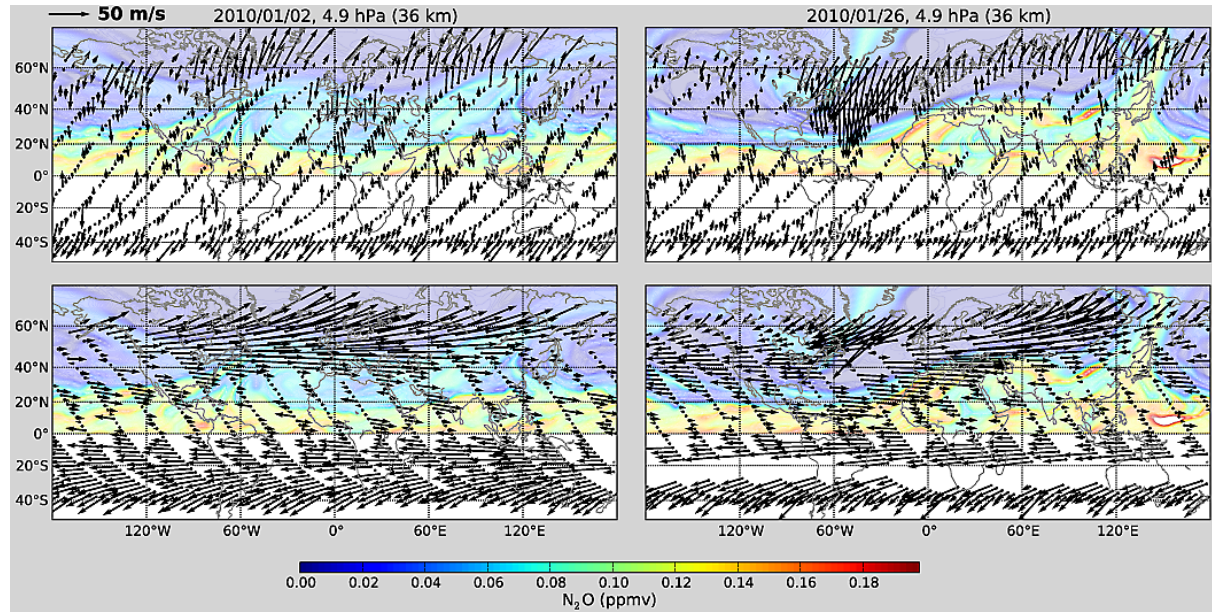
Fig. 3. Typical line-of-sight wind vectors retrieved at 5hPa ( ∼ 36km) on 2 January 2010 (left column) and on 26 January 2010 (right column). The orientation of the arrows is that of the wind component along the line-of-sight. The length of the arrows is proportional to the amplitude of the corresponding line-of-sight wind (the same proportional factor is applied at all latitudes). The upper (lower) panels correspond to the ascending (descending) branch of the orbit where the line-of-sight is near the meridional (zonal) direction between ∼ 35 ◦ S to ∼ 55 ◦ N. The background colour shows the northern N 2 O distribution from the assimilated Odin/SMR measurements in a model driven by ECMWF winds at the isentropic surface of 850K.